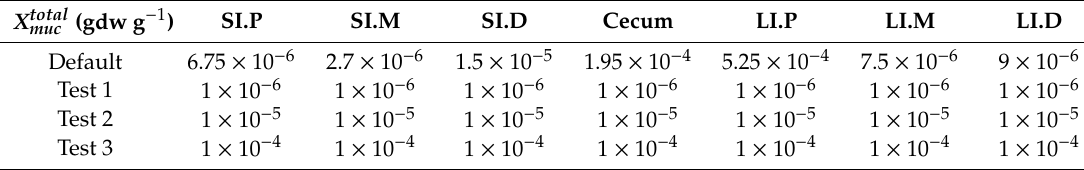
Table 2. Sets of values tested for the mucosal biomass density X total muc